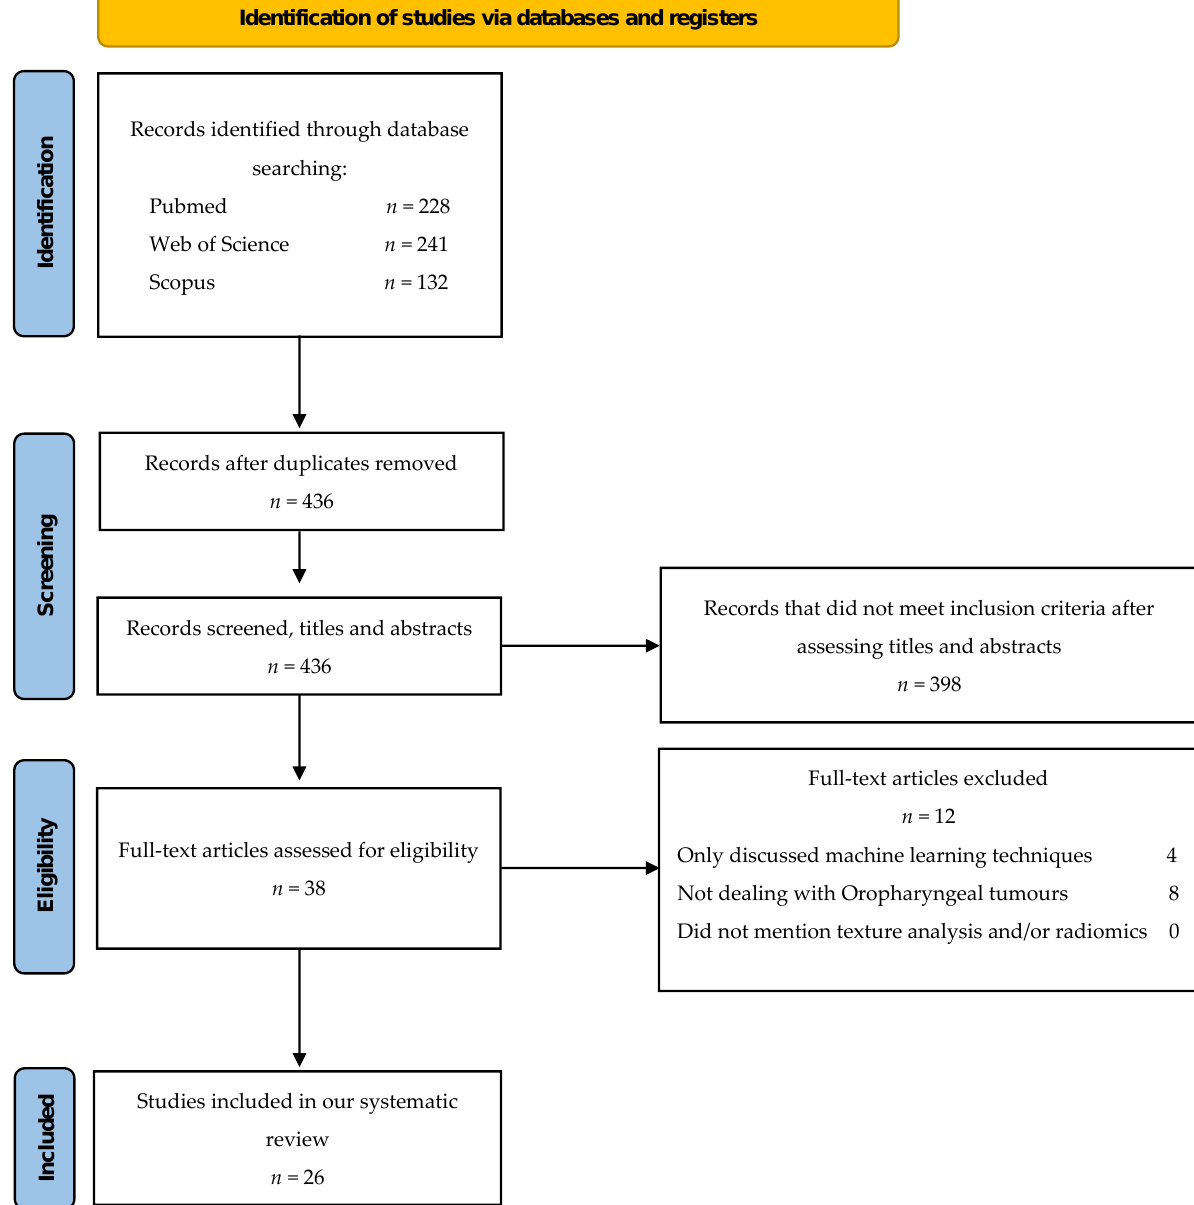
Figure 1. Flowchart consistent with preferred reporting items for systematic reviews (PRISMA 2020) statement.